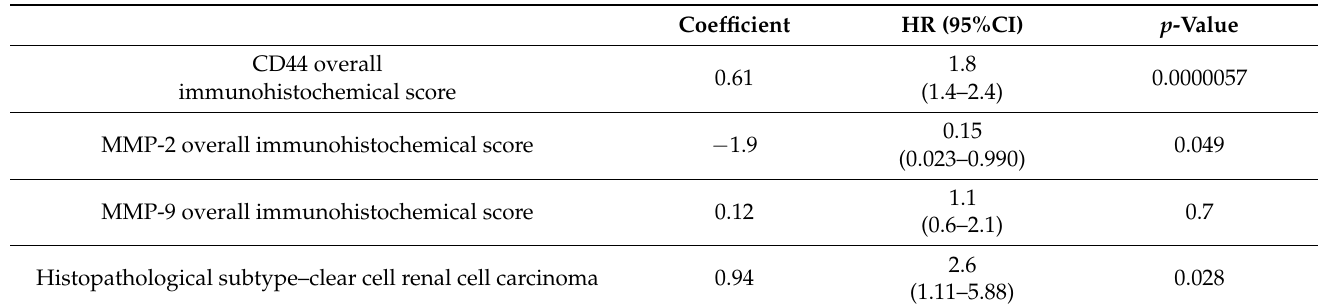
Table 4. Prognostic value of CD44, MMP-2, and MMP-9 expression levels and histopathological subtype of renal cell carcinoma for clinical outcome.